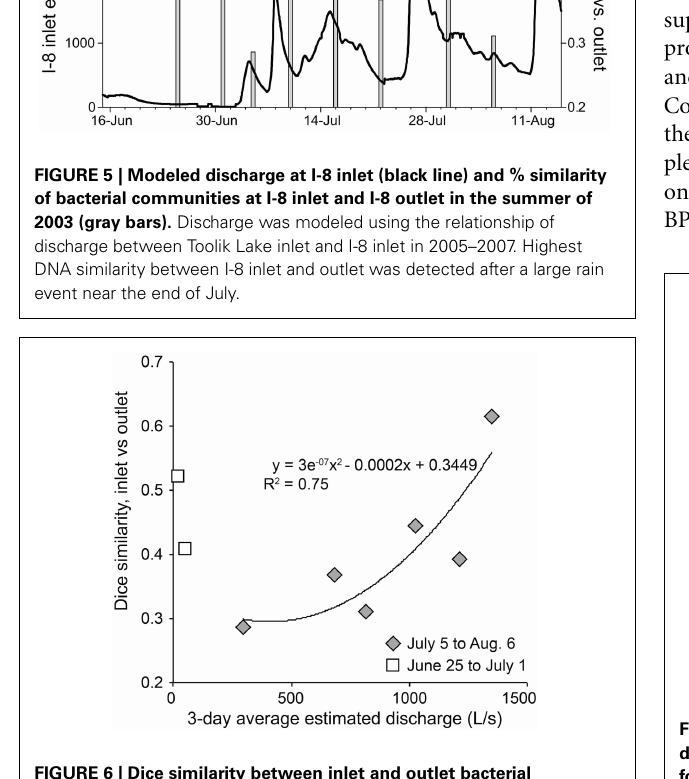
FIGURE 6 | Dice similarity between inlet and outlet bacterial community composition against the average estimated discharge for 3 days prior to community composition comparisons. A polynomial line is fit to samples collected after July 1.